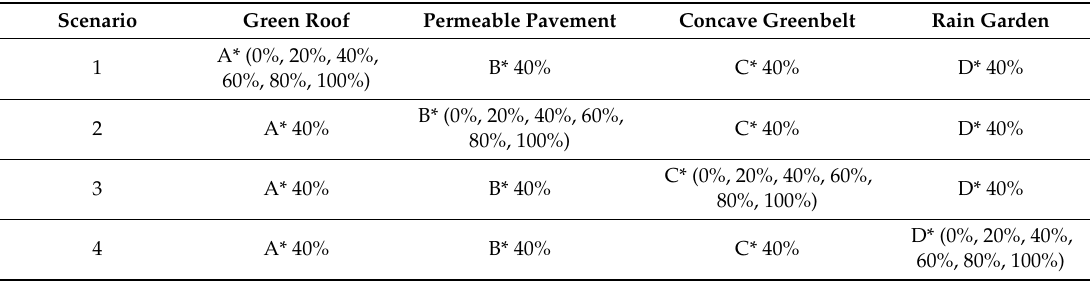
Table 5. The proportions of low-impact development (LID) facilities in the four scenarios.